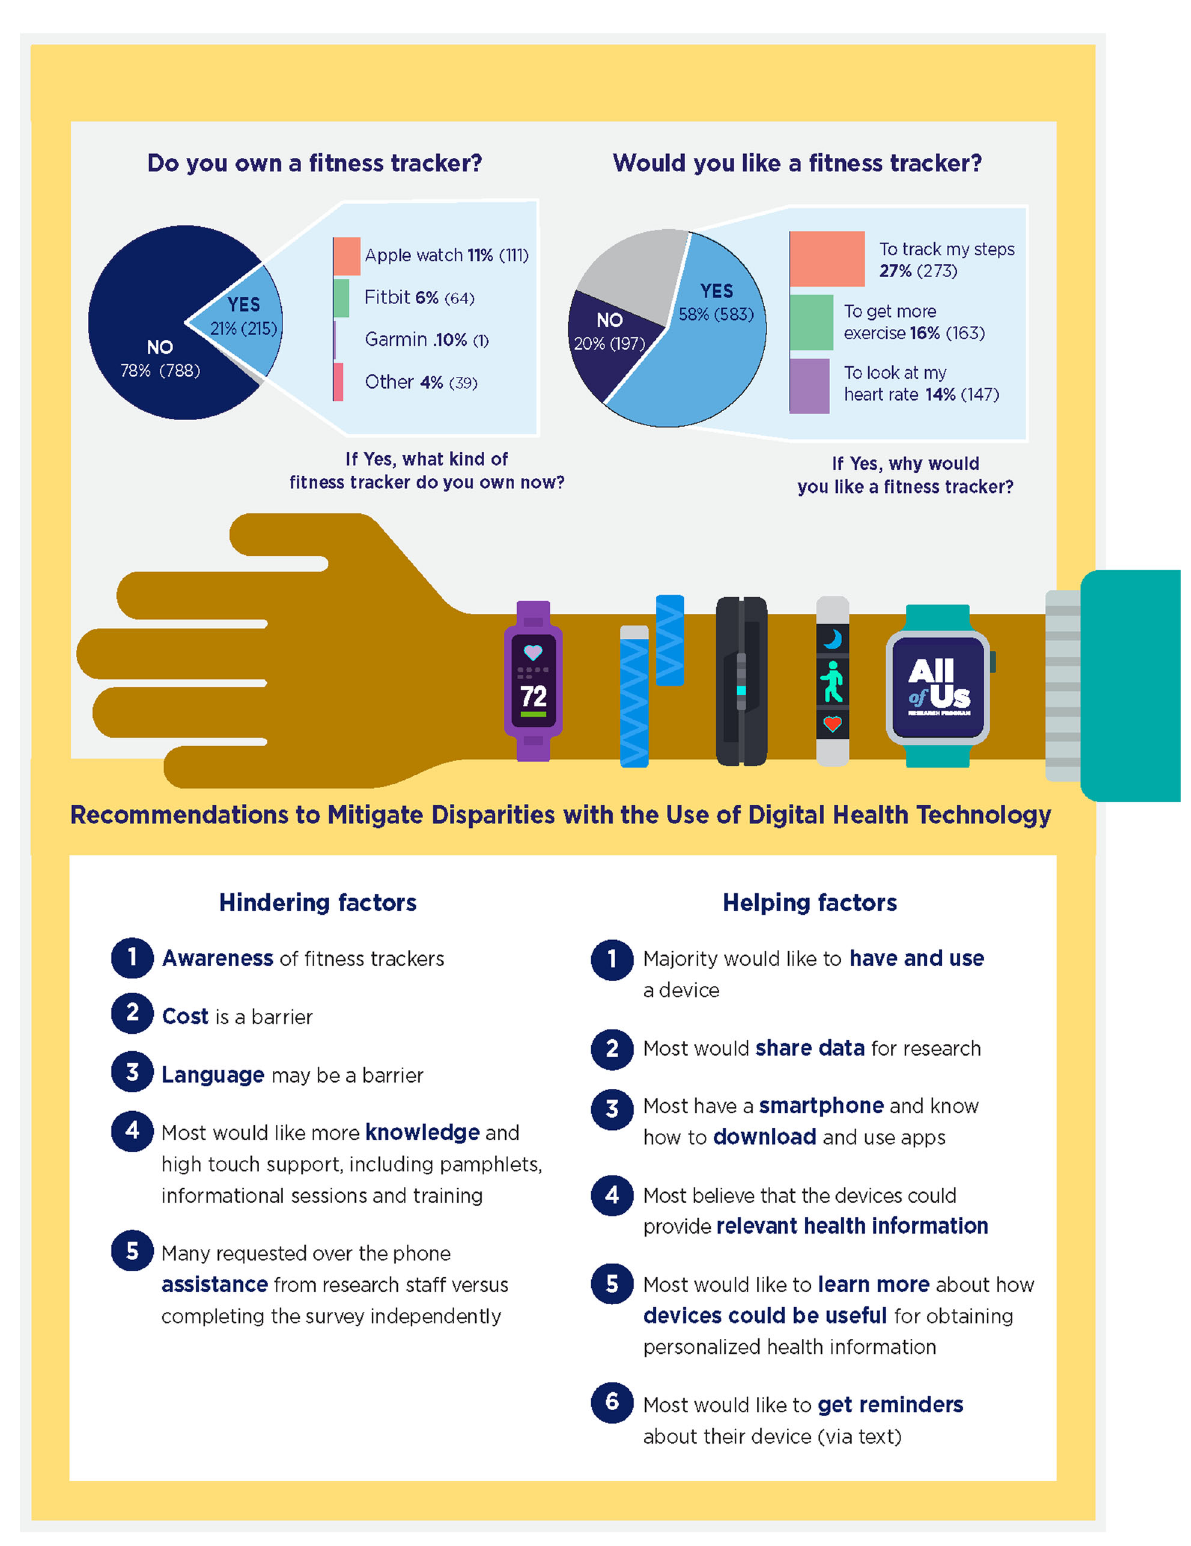
Fig. 2 Fitness tracker survey results. Participants were asked a variety of questions centered around their exposure to, ownership of, interest in, and familiarity with fi tness trackers. The top two pie charts illustrate participants ’ ownership and interest in fi tness trackers. Participants were also asked what kinds of things get in the way of owning a fi tness tracker. Those items were distilled and are listed under “ Hindering factors. ” Respondents were also asked about factors that they may consider helpful in reducing barriers to using a fi tness tracker, combined under “ Helping factors ” as recommendations for potential methods to mitigate disparities in digital health technology